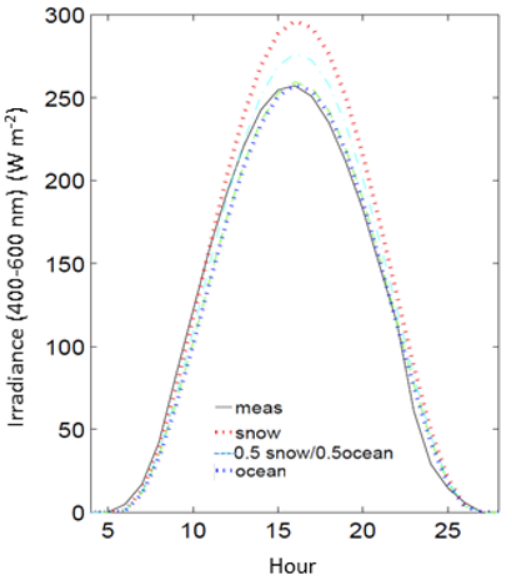
Figure 3. Measured irradiance (meas) for an example day at Palmer Station (ordinal day 300, 1990) compared to models of clear-sky irradiance using different surface albedos (snow, ocean and a 50% snow–ocean